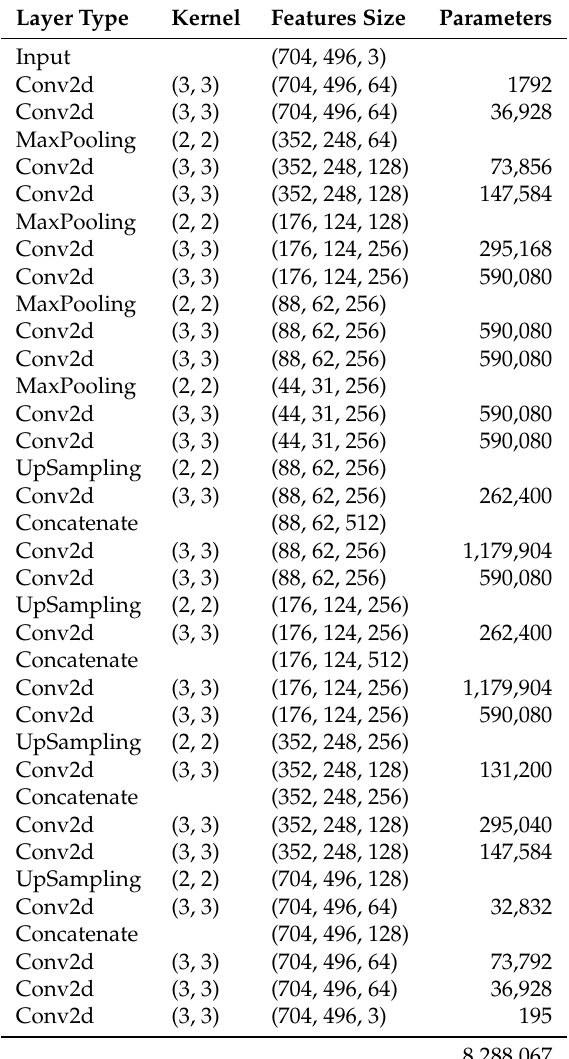
Table 1. Our Mini U-Net topology. The 704 × 496 (input-output) dimension is the 16 nearest multiple dimension to the target (700 × 500) size. Notably only ≈ 8 M parameters are used, well below the training dataset size of 420 MB uncompressed (72 MB compressed). Every layer except the last uses ReLU as its activation